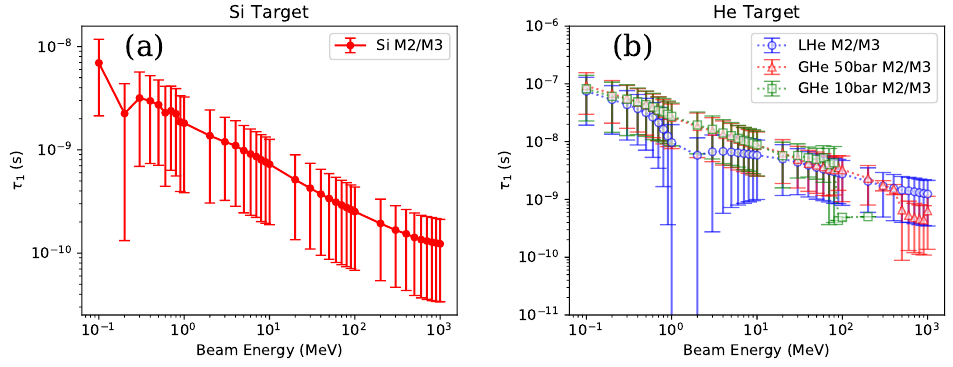
Figure 6. The distribution of the time between AB, τ 1 for ( a ) silicon target; ( b ) liquid helium target with the M3.